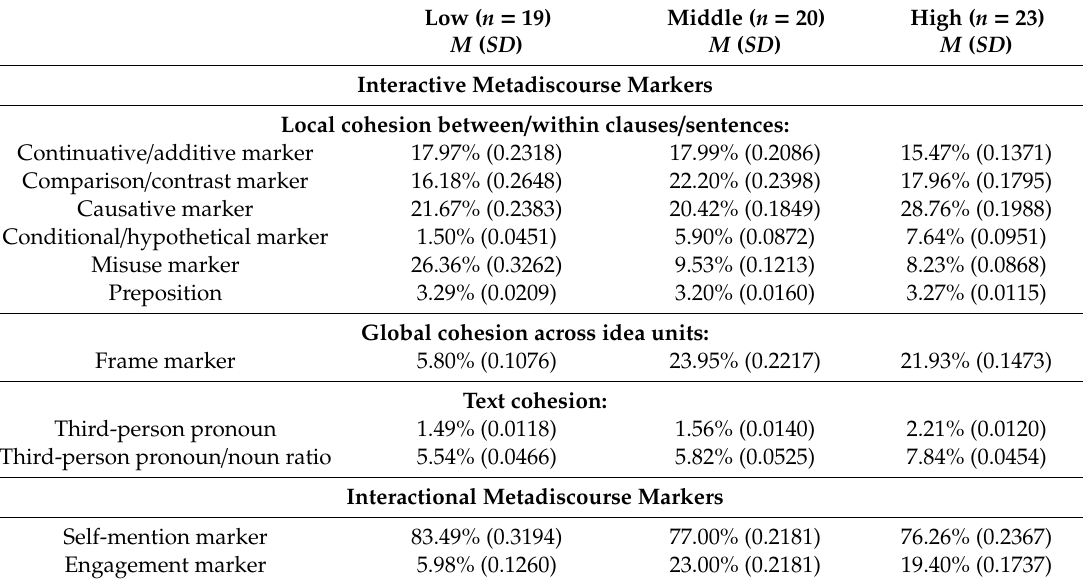
Table 3. Textual organizational measures descriptive